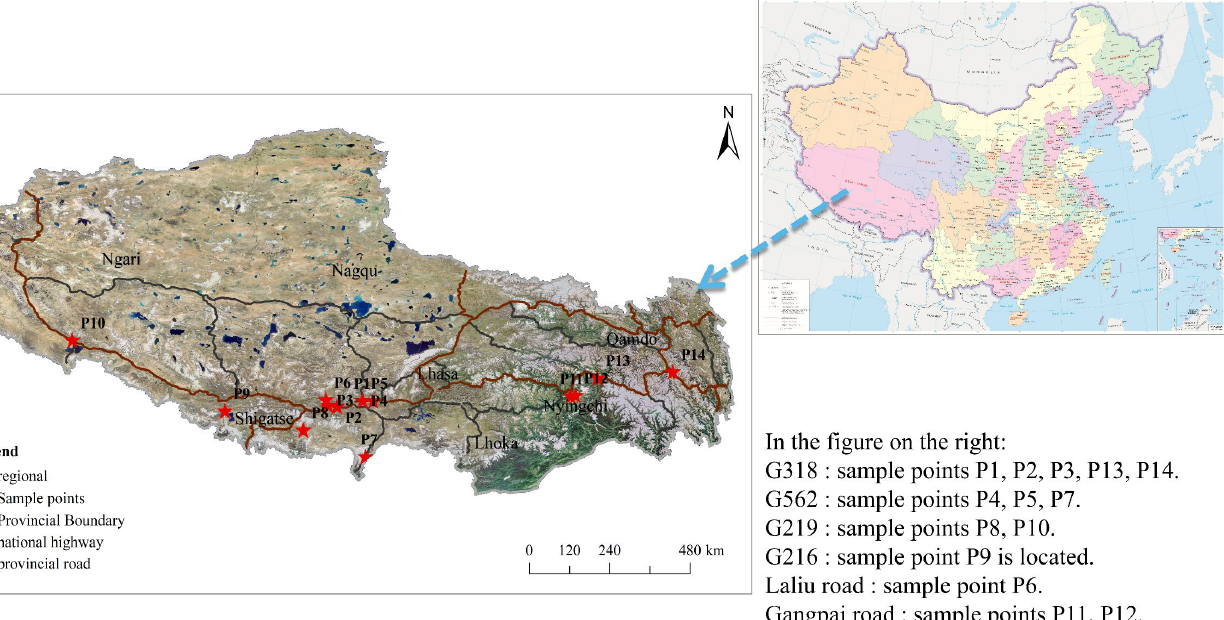
Figure 1. Locations of the sampling points in the study area.